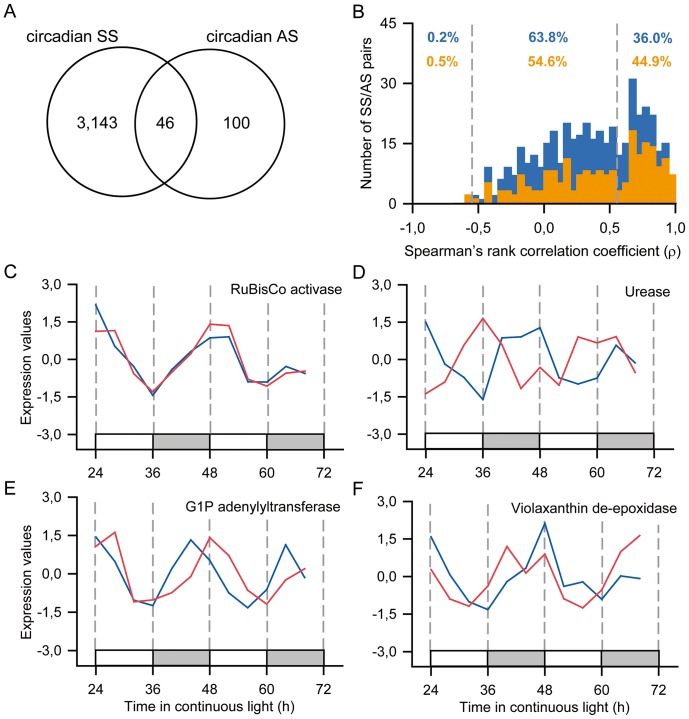
Sense and antisense transcripts are modulated differently by the circadian clock.(A) Overlap between SAS that had their probes for sense transcripts (SS) considered circadian and SAS that had their probes for antisense transcripts (AS) considered circadian. (B) Distribution of Spearman's rank correlation coefficient (ρ) for each of all the 428 pairs of SS/AS (light blue) and only the 207 pairs of SS/AS that had at least one probe considered circadian (orange). If ρ >0.56, correlation is positive and significant. If ρ <−0.56, correlation is negative and significant. (C to F) Z-score normalized expression levels of SS (red) and AS (dark blue) for a gene that have (C) both SS and AS in the same phase (RuBisCo activase; SCBGLR1044D06.g,), (D) SS and AS in opposite phases (urease, SCSGLR1045A02.g), (E) AS peaking before SS (glucose 1-phosphate adenylyltransferase, SCVPCL6061A06.g) and (F) SS peaking before AS (violaxanthin de-epoxidase, SCVPHR1095C07.g). White boxes represent periods of subjective day and light grey boxes represent periods of subjective night.